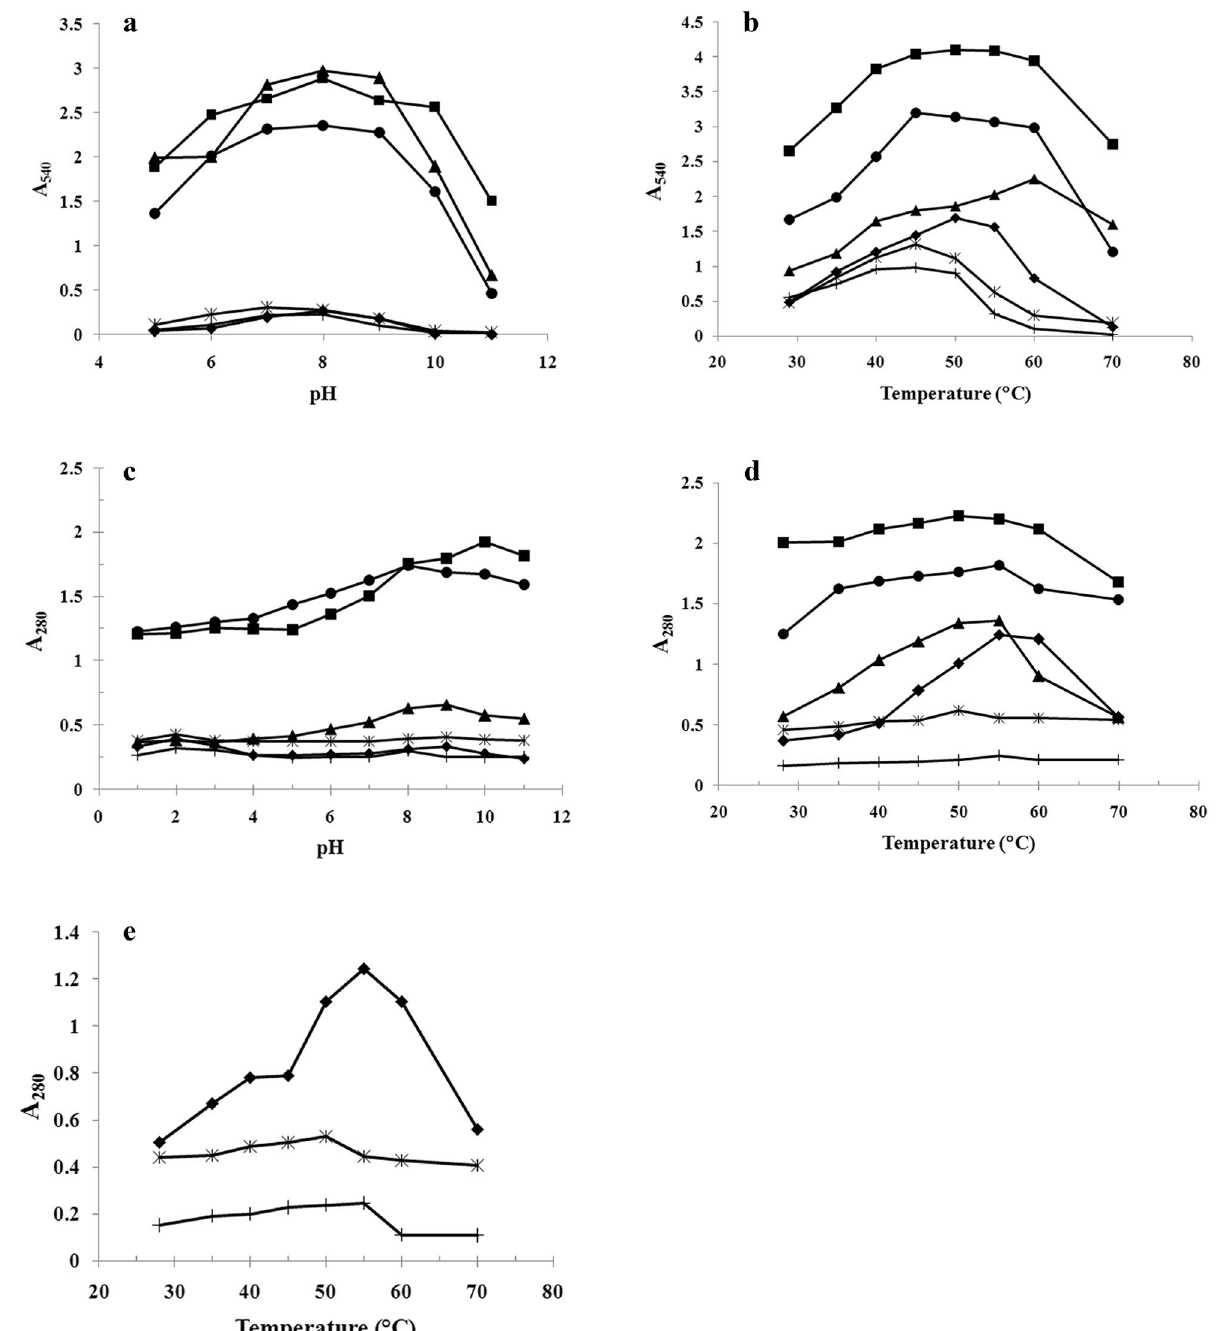
Figure 1. Optimum pH and optimum temperature for amylase ( a , b ), alkaline protease ( c , d ), and optimum temperature of pepsin-like enzyme ( e ) (- ■ -, Puntius gonionotus ; - Oreochromis niloticus ; -◆-, Hemibagrus spilopterus ; - * -, Kryptopterus geminus , - + -; Ompok bimaculatus